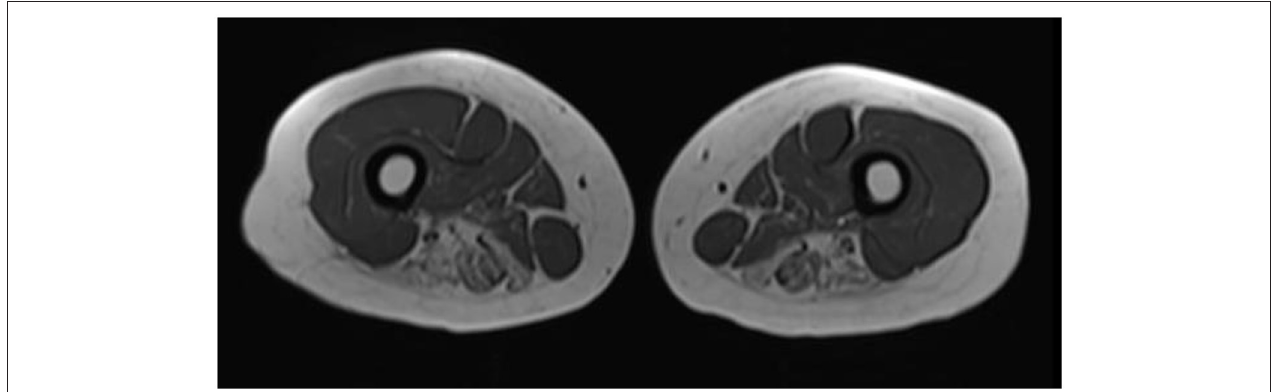
FIGURE 1 | Muscle MRI of upper legs. In this representative transverse axial T1 weighted image from the patient, increased signal intensity is seen in the bilateral adductor magnus, semitendinosus, and semimembranosus